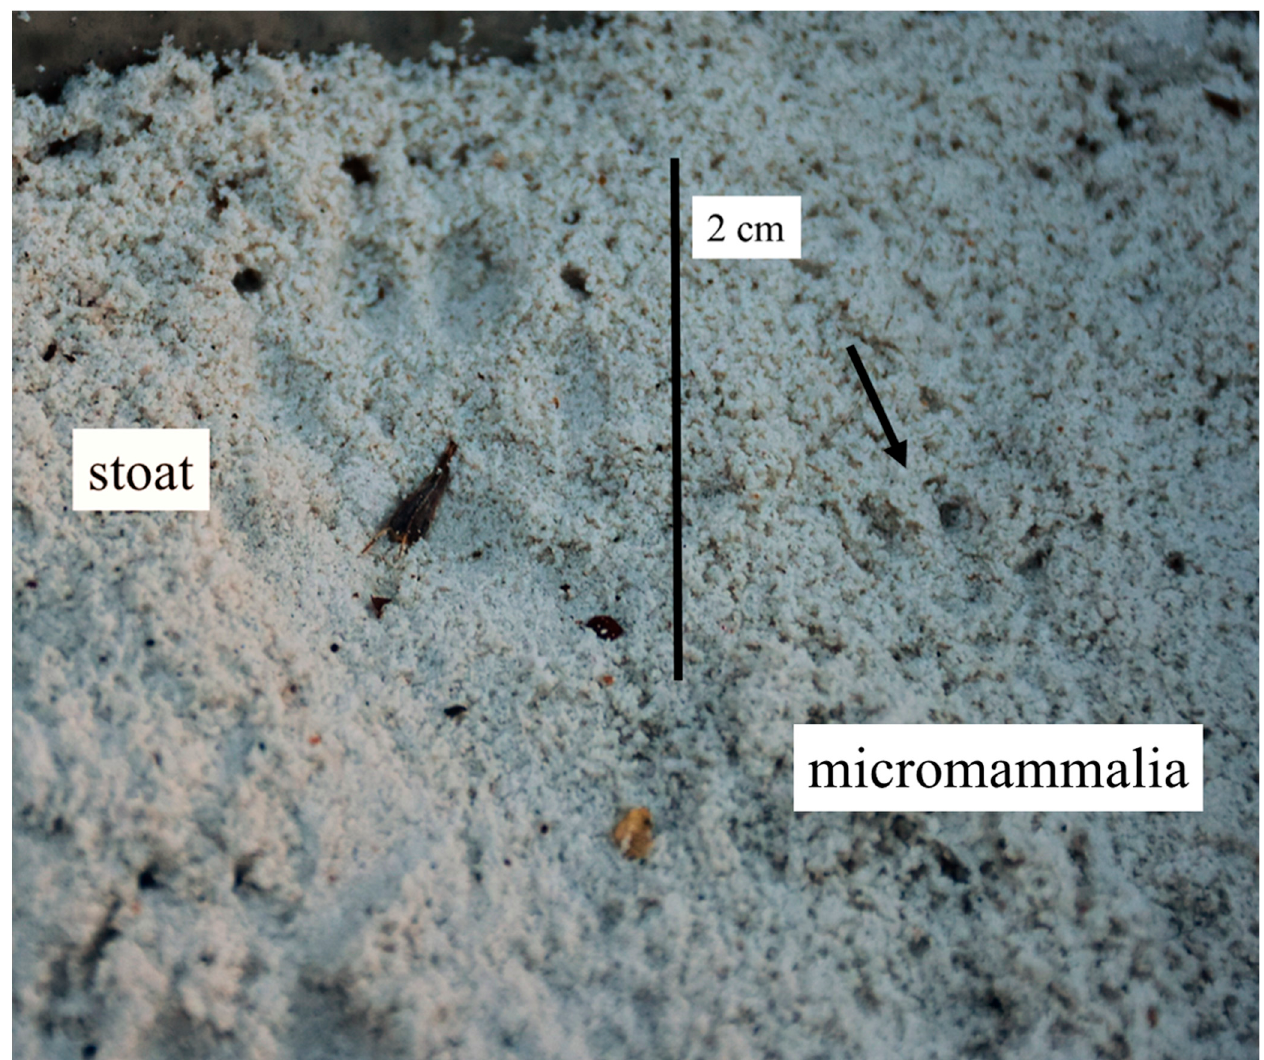
Figure 3. Example of a kinetic sand surface retrieved from a tracking tunnel. Three examples of single mammal tracks are indicated; 5 × 5 cm squares are given for comparison (photo by Z. Wikar).